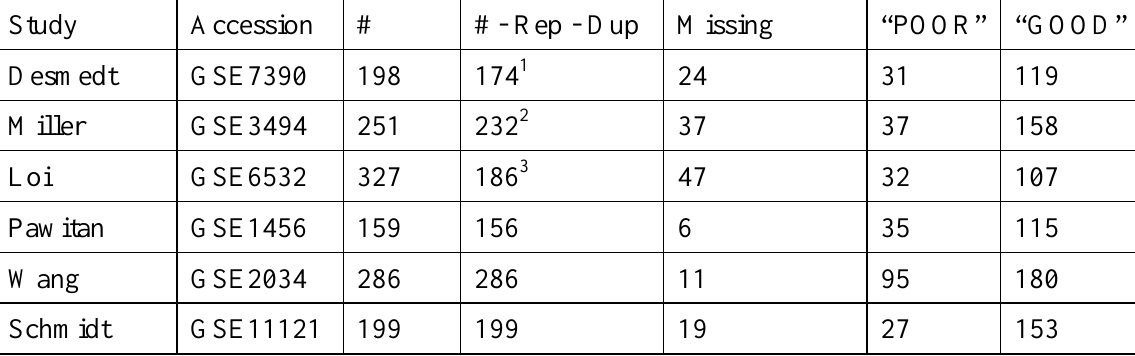
Table 1: Overview of studies. Statistics on the six studies employed. Accession, #, # - Rep – Dup, Missing, “POOR” and “GOOD” refer to the accession code and the number of samples available at GEO, the number of samples after removal of replicates and duplicate samples, the number of samples with incomplete metadata or prematurely ended censoring, the number of “POOR” prognosis samples and the number of “GOOD” samples respectively. 1) Replicates (Desmedt/Loi) were removed from Desmedt. 2) Replicates (Desmedt/Miller) were removed from Miller. 3) Duplicates (Miller/Loi) were removed from